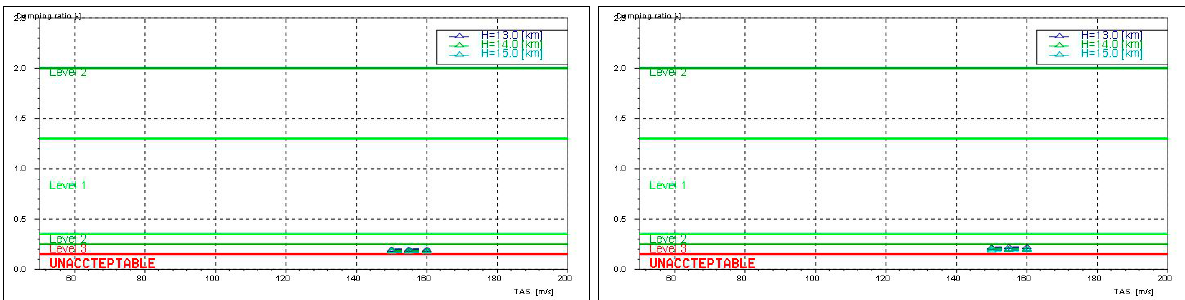
Fig. 13. The damping ratio stability criterion based on the MIL regulation for configuration No. 1 (on the left) and configuration No. 2 (on the